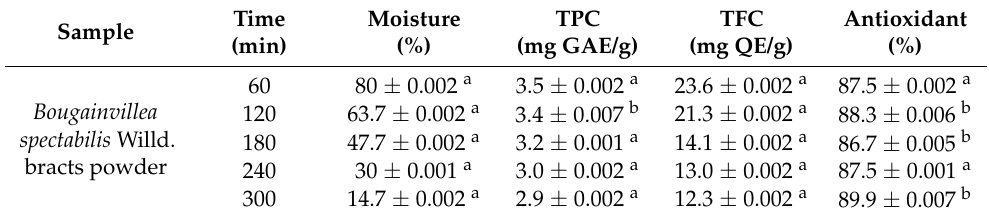
Table 2. Phytochemical parameters of Bougainvillea spectabilis Willd. bracts powder. Sample